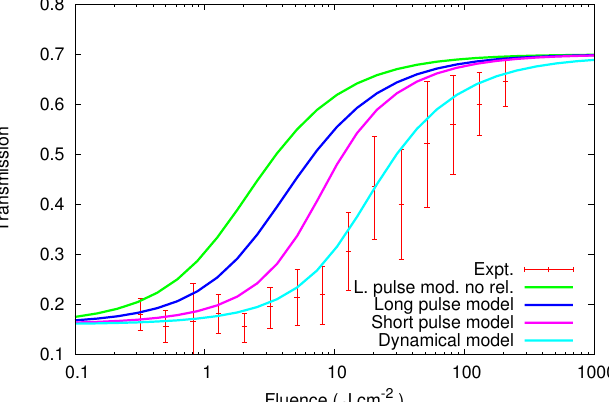
Figure 1. XFEL pulse transmission for Al thin film (53 nm) at 92 eV photon energy. The green and blue solid lines indicate long pulse model without (no rel.) and with an intermediate relaxed state; that is, the model of the green line is just a two-channel model. The pink solid line is for the short pulse model. The light blue solid line corresponds to the three-channel dynamical model. The dynamical model agrees very well with the experimental (Expt.) data